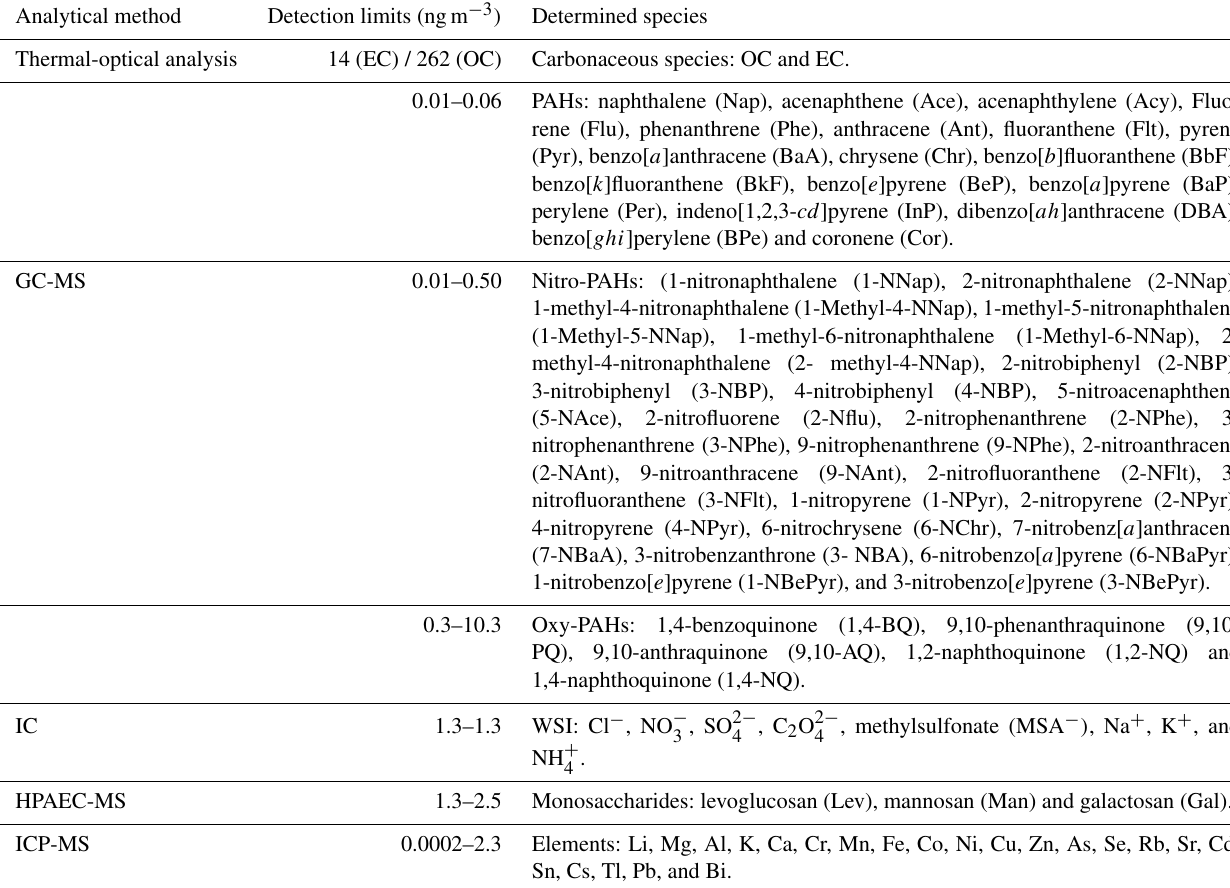
Table 2. Details of the analyzed species, analytical methods and detection